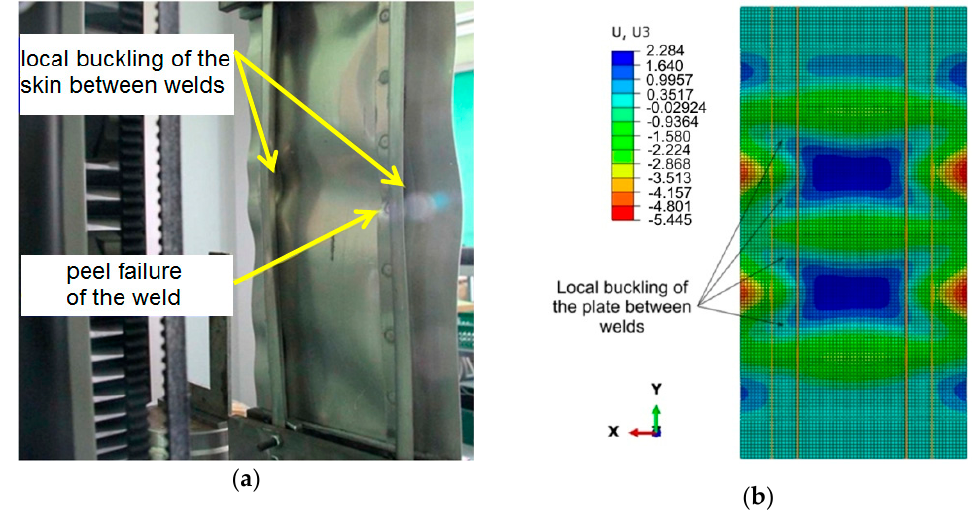
Figure 15. Deformation of a welded panel with a weld spacing of s = 44.25 mm subjected to a compressive force of 37.5 × 10 3 N: ( a ) Experimental test, ( b ) numerical modeling.